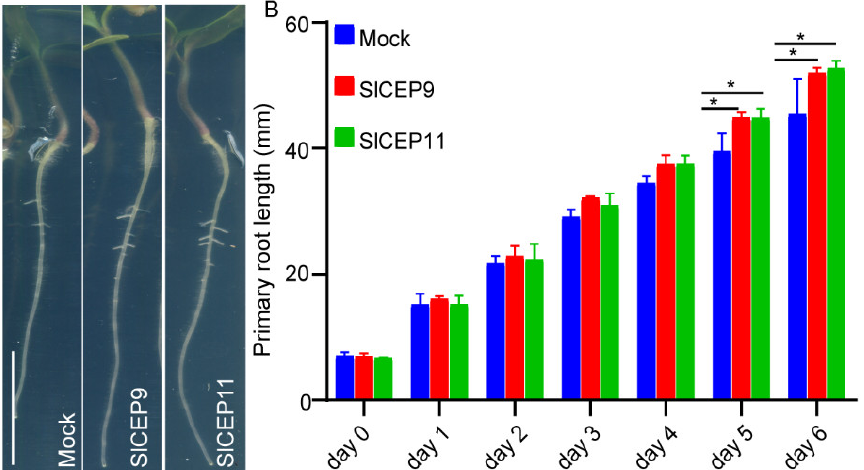
Figure 4. SlCEP9 and SlCEP11 peptide promote tomato root growth. ( A ) Representative images showing the SlCEP9 and SlCEP11 peptide-treated tomato primary root for 6 days. ( B ) Quantification of tomato primary root length upon synthetic SlCEP9 and SlCEP11 peptide treatment for 6 days. n = 10–15 seedlings, data represent mean ± SD, * p < 0.05 was determined by one-way ANOVA. Scale bar = 1 cm.